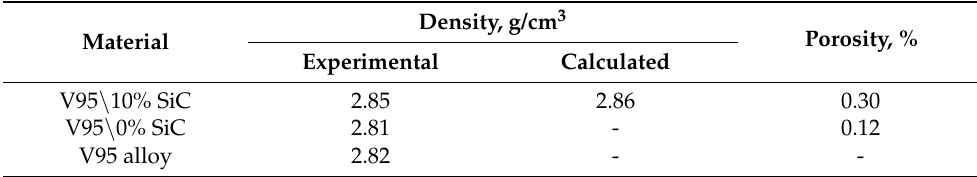
Table 1. The density and porosity of the